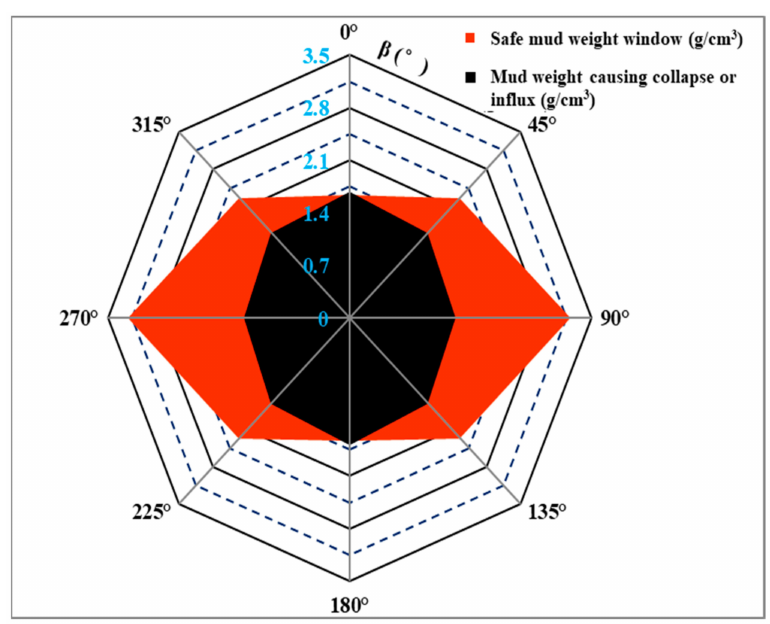
Figure 8. Safe mud weight window of the target zone with ∆ p p / p p = 0.4.